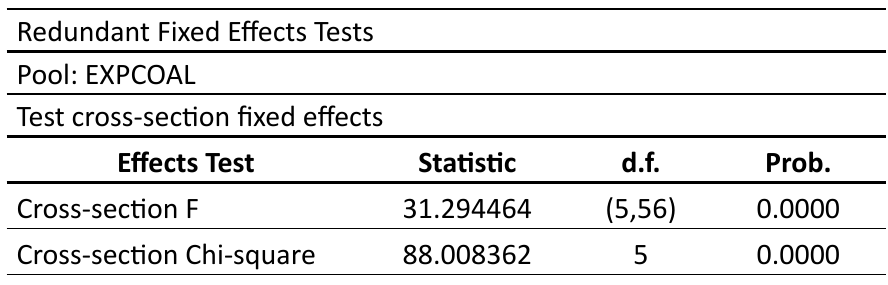
Table 2: Result of the Chow-test